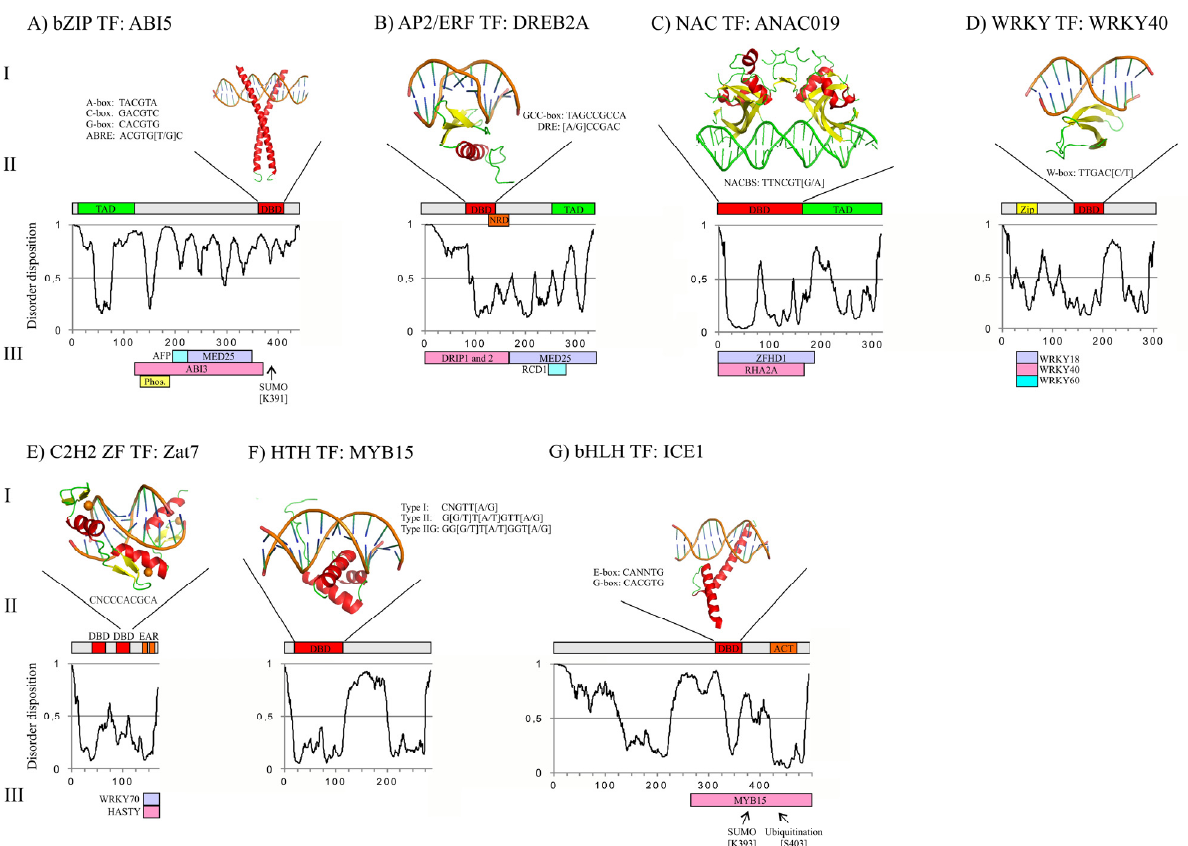
Figure 2. Structure of well-studied members of the bZIP, AP2/ERF, NAC, WRKY, C2H2 ZF, HTH and bHLH TF families. (I ) Tertiary structure of the TF family designating DBD in complex with DNA. ( II ) Schematic primary structure drawn to scale and disorder predictions for a selected TF. ( III ) Regions involved in protein-protein interactions and post-translational modifications. ( A ) X-ray structure of the bZIP DBD from mouse CREB (PDB accession code 1DH3) and schematic representation of the bZIP TF ABI5. ( B ) NMR structure of the ERF DBD from Arabidopsis ERF1 (1GCC) and schematic representation of the AP2/ERF TF DREB2A. ( C ) X-ray structure of the NAC DBD from Arabidopsis ANAC019 (3SWP) and schematic structure of ANAC019. ( D ) NMR structure of the WRKY DBD from Arabidopsis WRKY4 (2LEX) and schematic representation of WRKY40. ( E ) X-ray structure of the C2H2 ZF DBD from mouse Zif268 and schematic representation of Zat7. ( F ) NMR structure of the HTH domain, part of the MYB DBD, from human TRF2 and schematic representation of MYB15. ( G ) X-ray structure of the bHLH DBD from mouse MyoD and schematic representation of